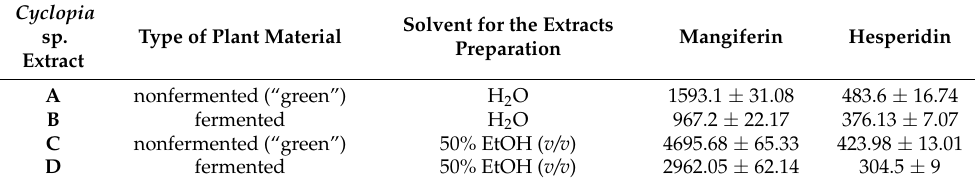
Table 1. Summary of content of mangiferin and hesperidin [ng/mL] in Cyclopia sp. extracts analysed by HPLC-UV. Cyclopia